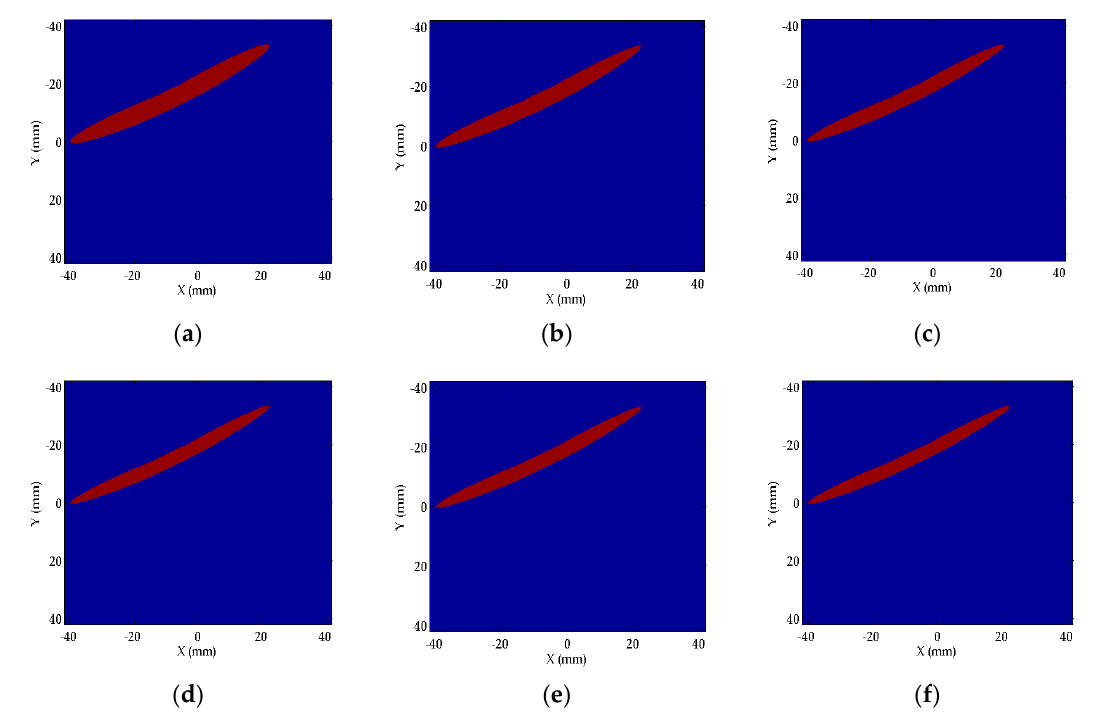
Figure 5. The Fresnel zone regulated by 𝑛 between transmitter 𝐴 and receiver 𝐵 when ( a ) 𝑛 = 1 ; ( b ) 𝑛 = 2 ; ( c ) 𝑛 = 3 ; ( d ) 𝑛 = 4 ; ( e ) 𝑛 = 5 ; ( f ) 𝑛 = 8 .